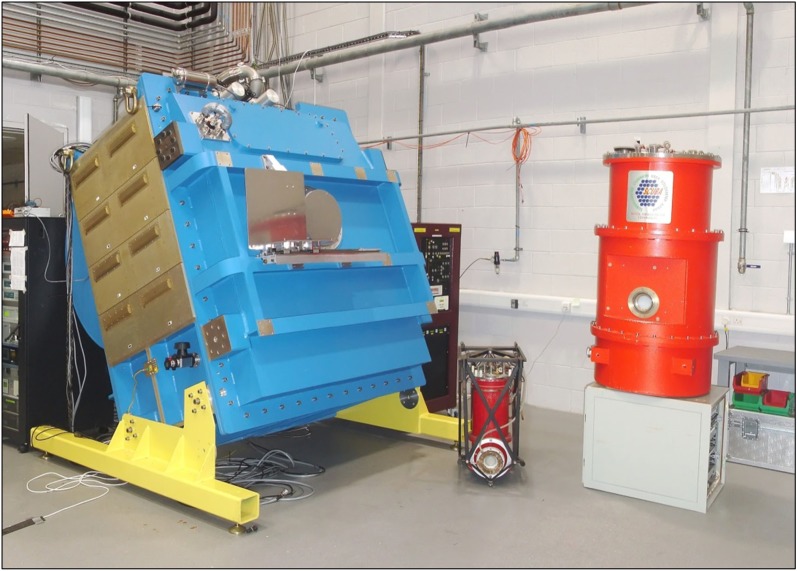
The JCMT continuum instruments together in the ROE Crawford laboratory, prior to the delivery of SCUBA-2 to JCMT (left) SCUBA-2 (10 000 pixels) (centre) UKT14 (1 pixel) and (right) SCUBA (128 pixels). SCUBA now resides in the National Museum of Scotland in Edinburgh. Photograph courtesy of the Royal Observatory Edinburgh.